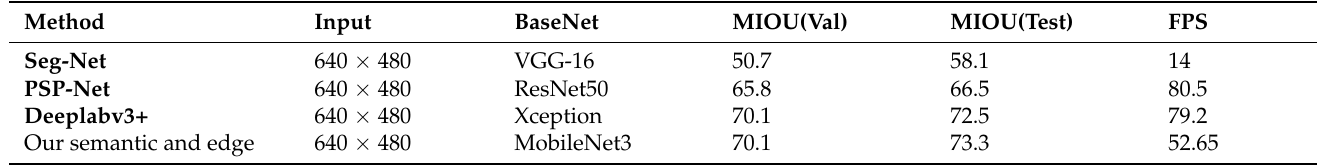
Table 2. Accuracy and speed of image semantic segmentation network on NYU-V2 dataset.